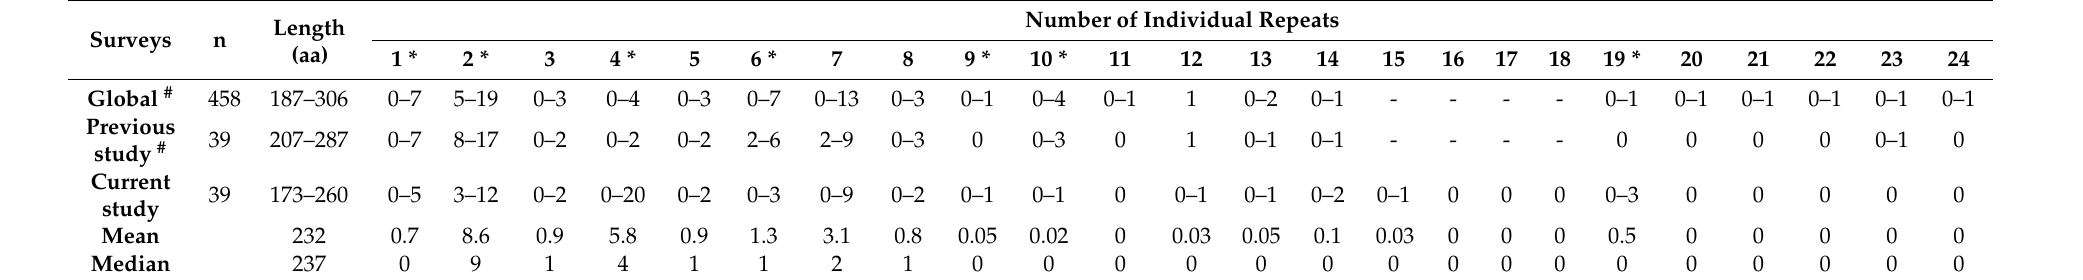
Table 2. Comparison of amino acid mean length and frequency of each repeat in PfHRP2 in parasites from previous and current studies in